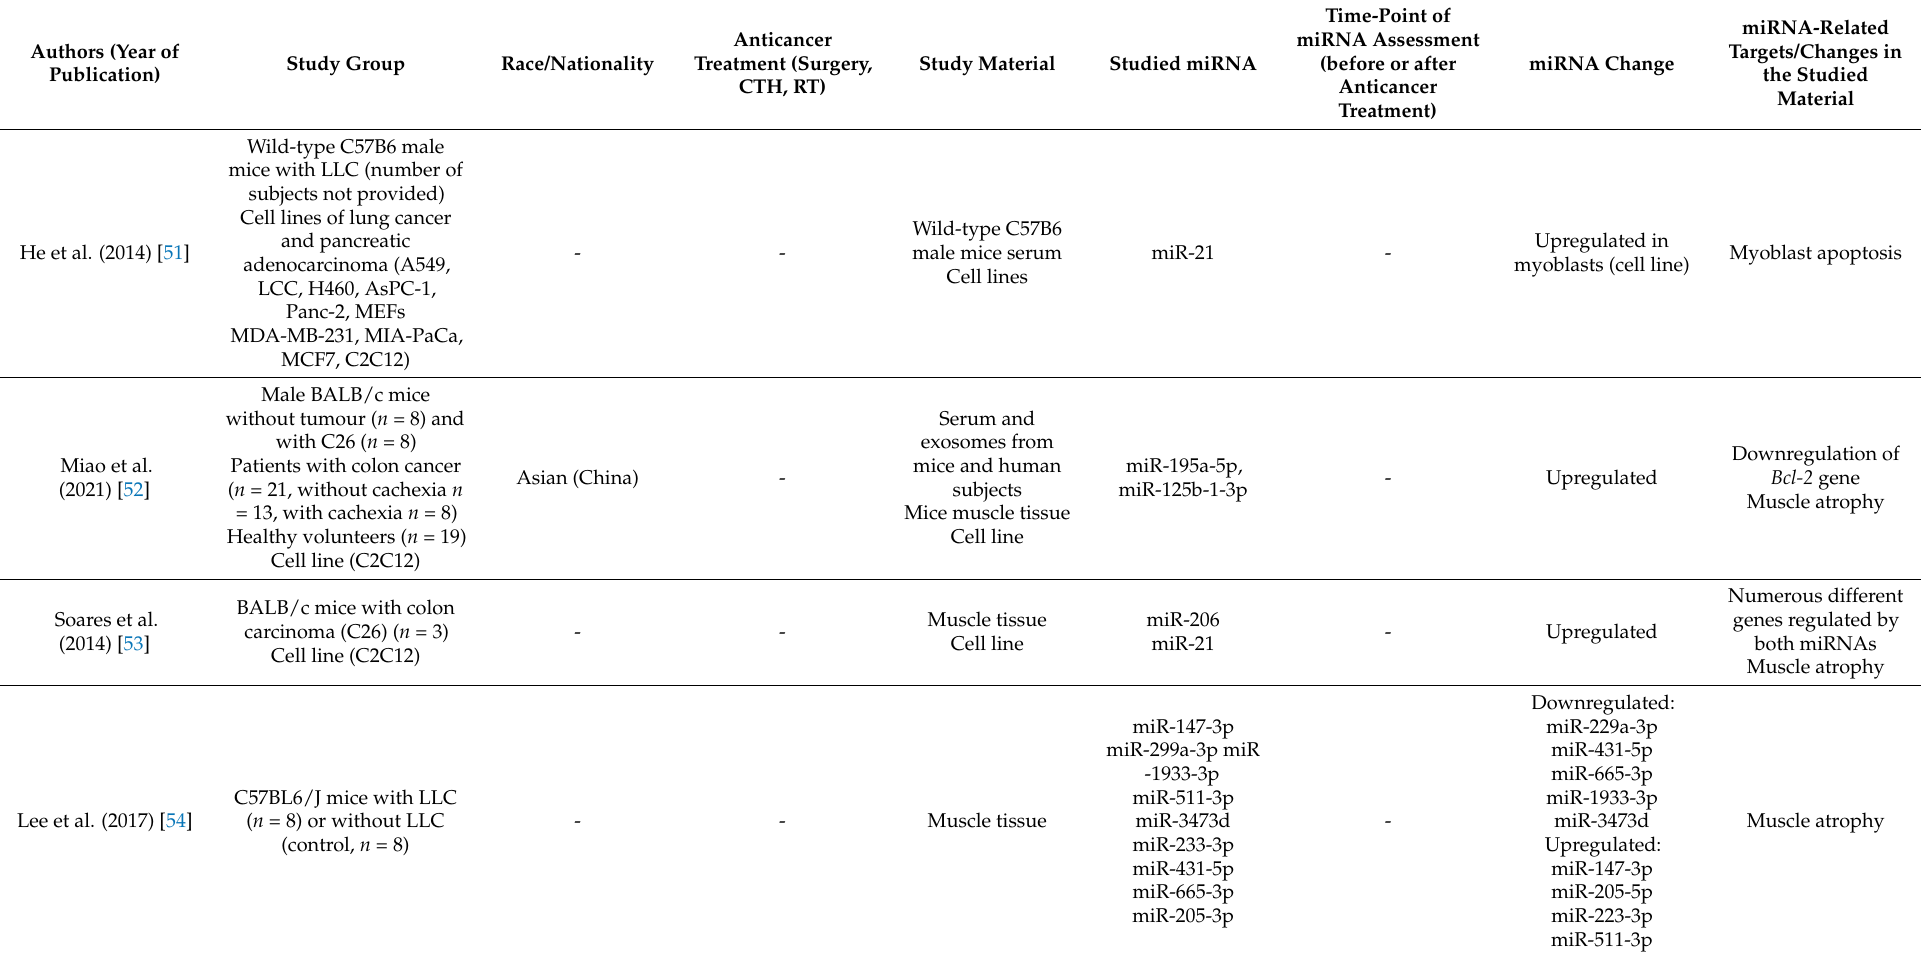
Table 3. The role of miRNAs in cancer cachexia-related muscle tissue